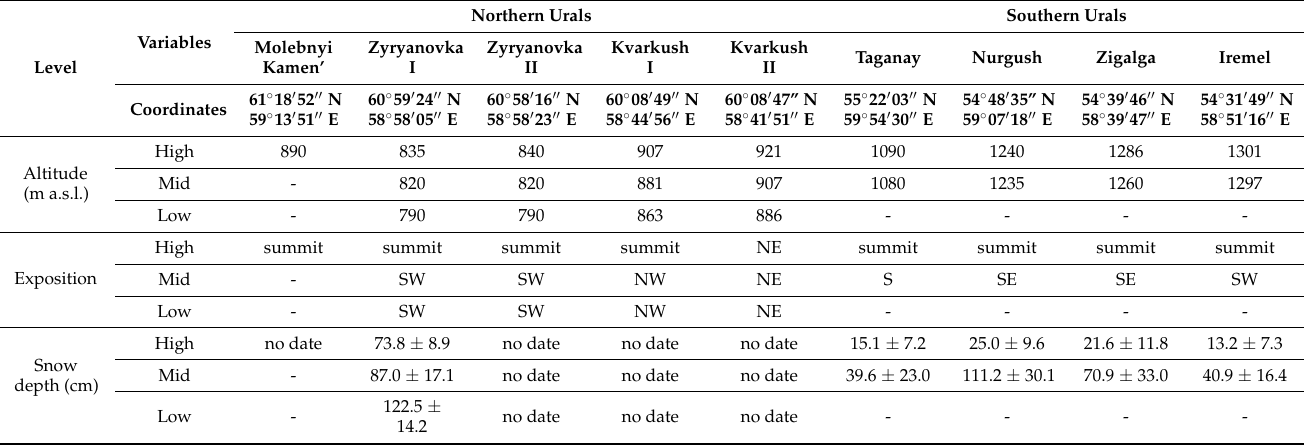
Figure 2. Climate diagrams of study regions in ( a ) Northern and ( b ) Southern Urals. The red line shows the annual dynamics of the mean monthly air temperature; the blue bars correspond to the total monthly precipitation.